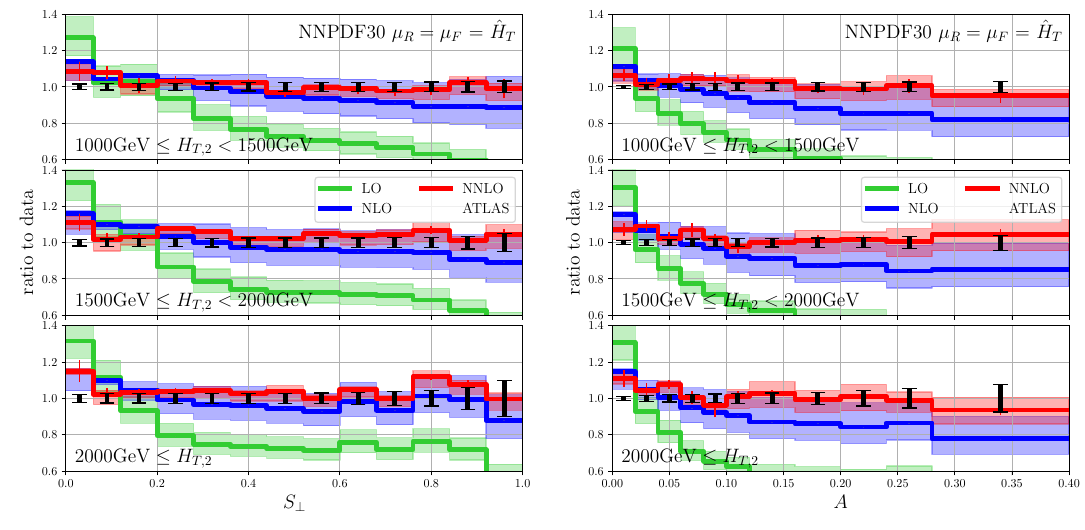
Figure 2 . As in figure 1 but for the transverse sphericity S ⊥ (left) and the aplanarity A (right).